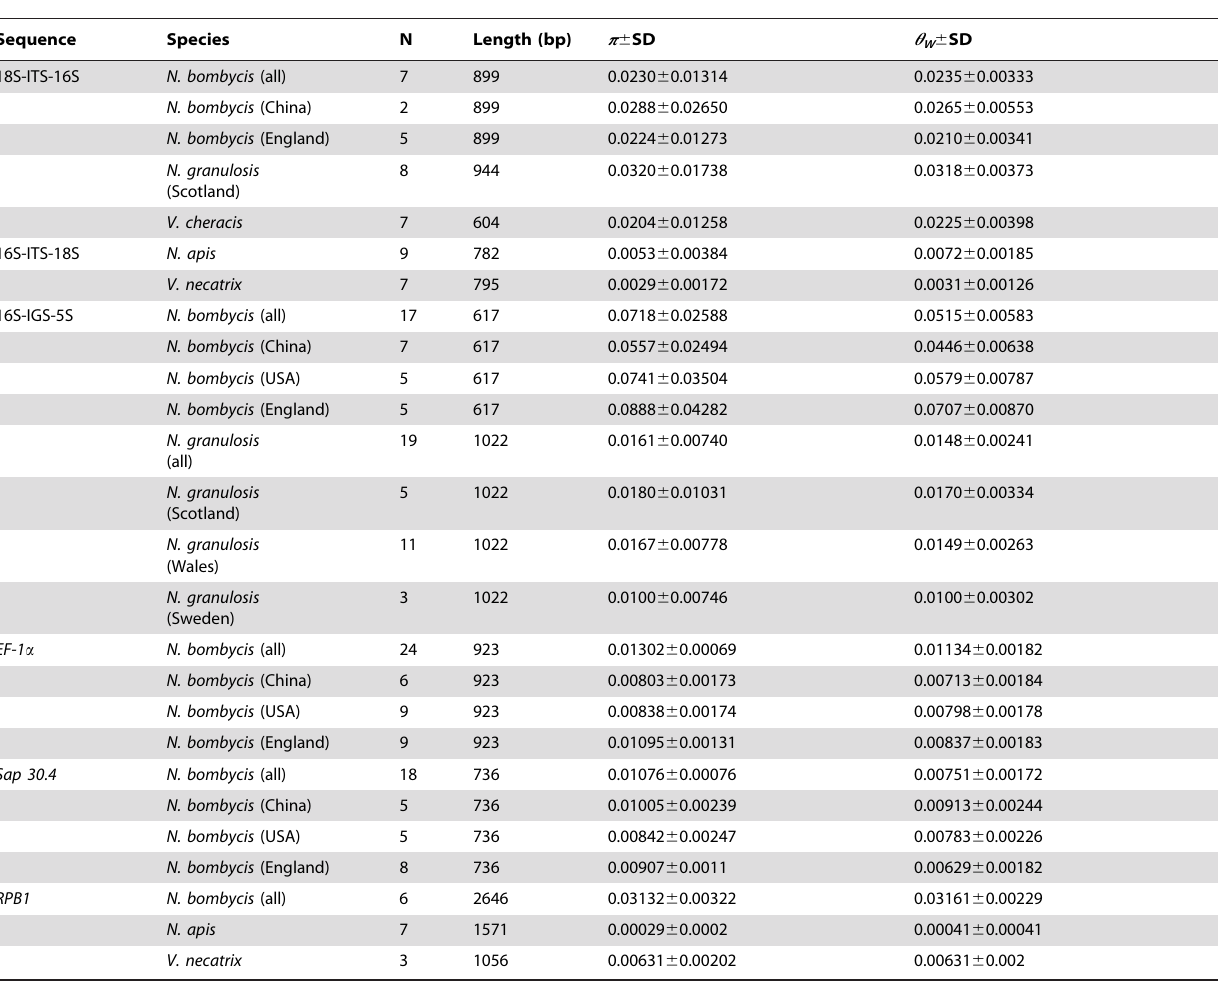
Table 7. Genetic diversity in cloned sequences from Nosema